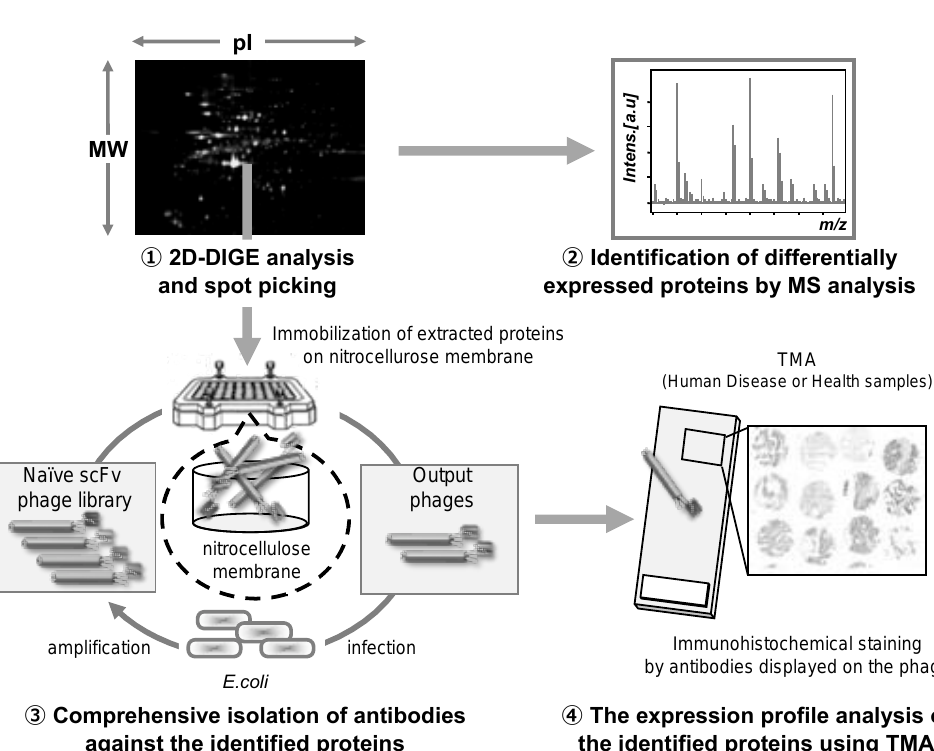
Figure 3. Schematic illustration of the antibody proteomics system. (1) Candidate proteins are detected using two-dimensional differential in-gel electrophoresis (2D-DIGE) and (2) identified by mass spectrometry analysis (MSA). Simultaneously, (3) monoclonal antibodies against all the proteins identified by 2D-DIGE are produced using a phage antibody library. Finally, (4) the proteins are validated as biomarkers and therapeutic targets using tissue microarray (TMA). Therefore, using this technology, the candidate proteins can be comprehensively validated, and the most useful proteins can be selected.